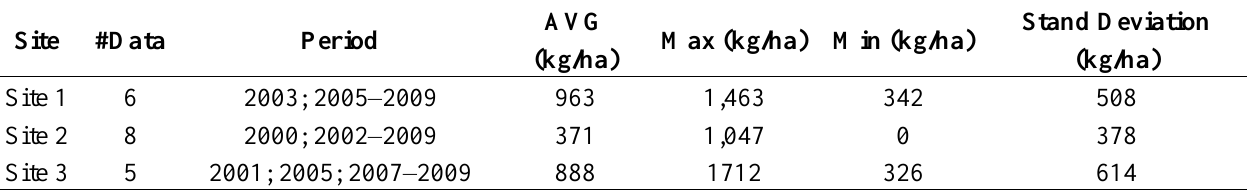
Table 1. Field data cardinality and average sampled values of the three field biomass measurements.